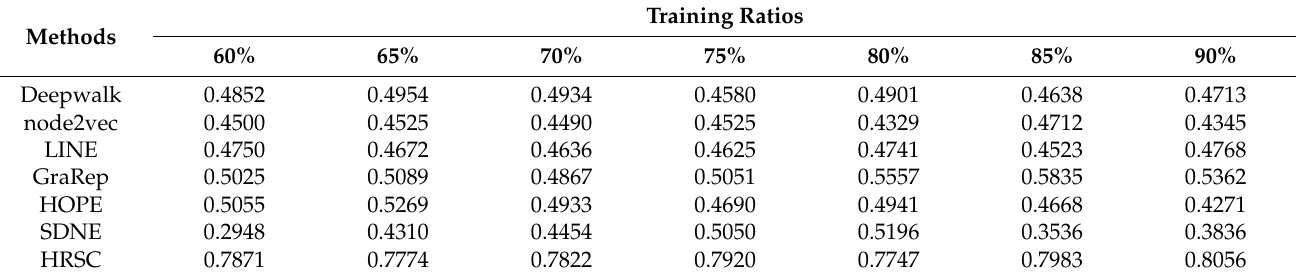
Table 7. AUC values on